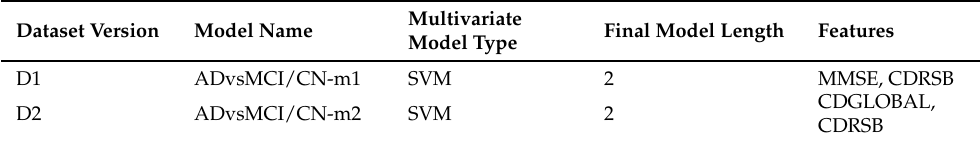
Table 4. Most important features for classification of patients with Alzheimer’s obtained through the GA.